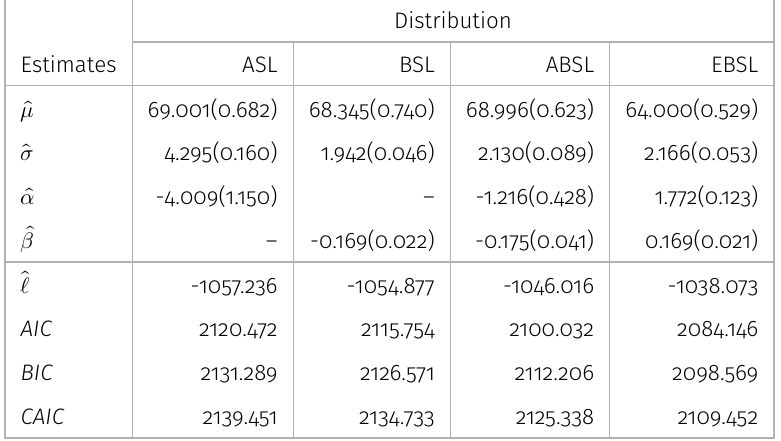
Table II. Parameter estimates (S.E) of the fitted models to the old faithful geyser data